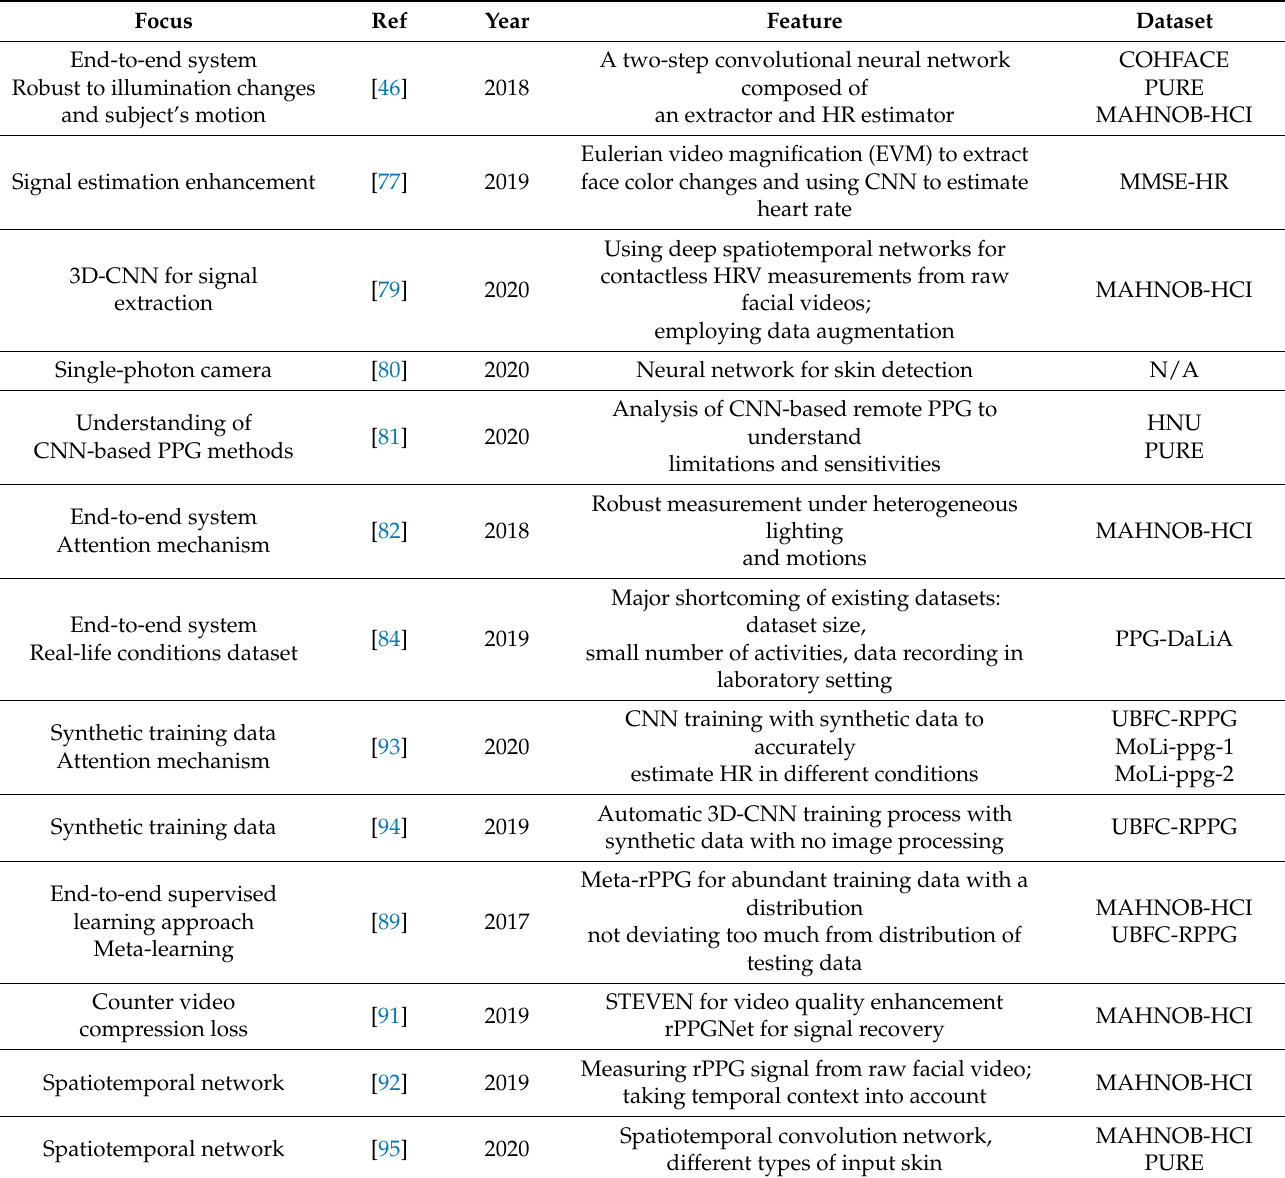
Table 3. Deep learning-based contactless PPG